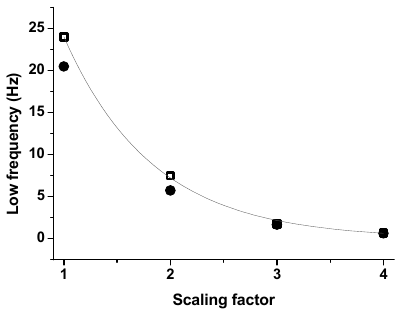
Figure 14. High-frequency oscillations. Dependence of the oscillation frequency on the scaling factor. Unfortunately, there are no available experimental data referring to acoustic radiation of vertical gaseous cylindrical vortexes.